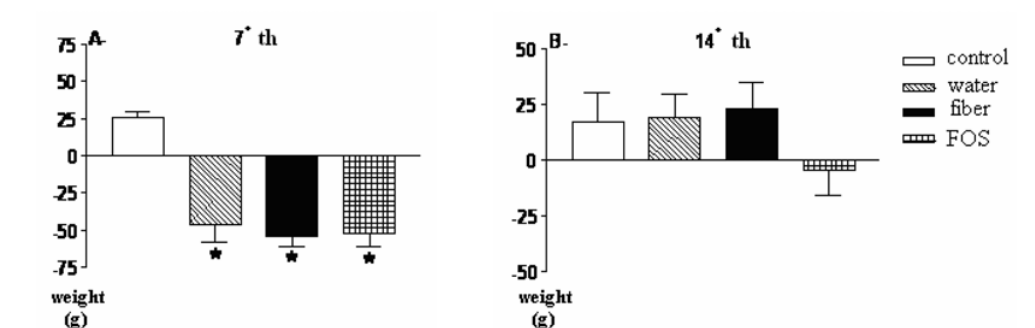
FIGURE 1 - Effect of soluble fiber or fructooligosaccharide (FOS) supplementation upon the body weight of rats with colitis induced by transrectal administration of trinitrobenzene sulphonic acid (TNBS) dissolved in ethanol. The animals were weighed 7 days (Panel A) or 14 days (Panel B) following induction. The results are expressed as average values ± MSE per group eight animals. (*) p <0.05 compared to the control group. Kruskal Wallis